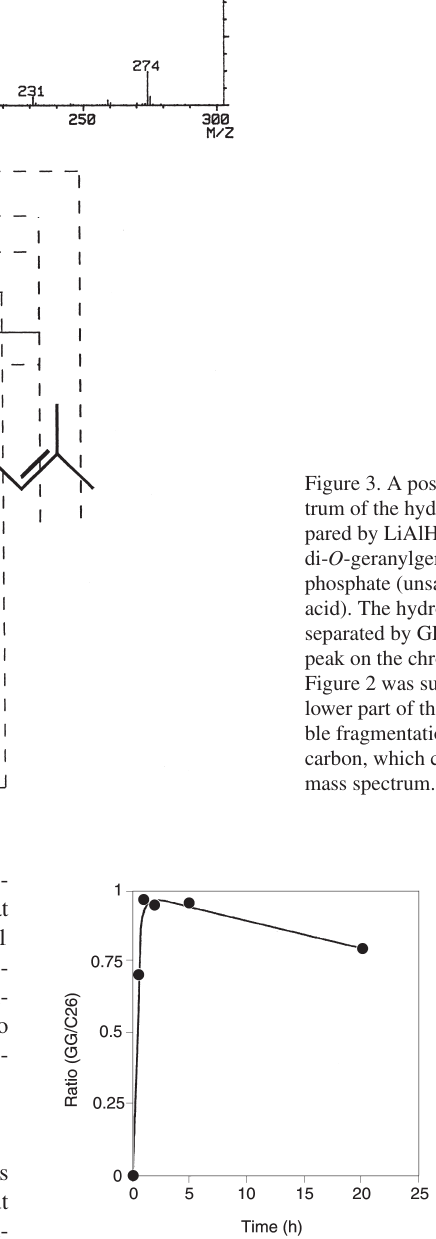
Figure 4. Time course of LiAlH 4 cleavage reaction of an allyl ether. 2,3-Di- O -geranylgeranyl- sn -glycerol-1-phosphate was reacted with LiAlH 4 as described in Materials and methods. Samples were taken at the times indicated and analyzed by GC. The ratio of peak areas of 2,6,10,14-tetramethylhexadec-2,6,10,14-tetraene to the internal stan- dard was